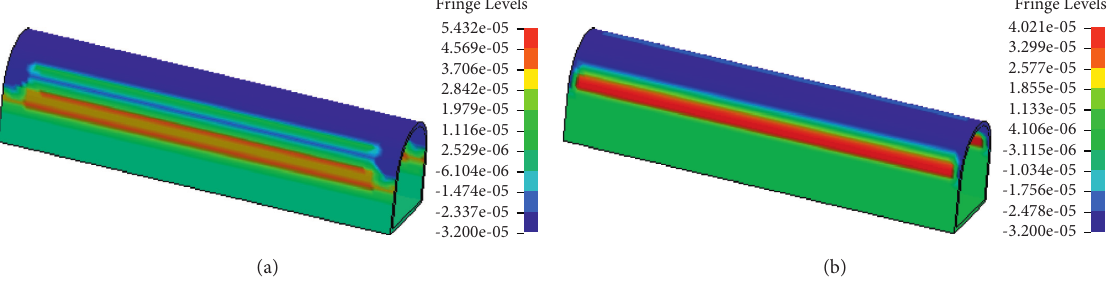
Figure 4: The lining stress of the existing tunnel: (a) condition 1 and (b) condition 2.